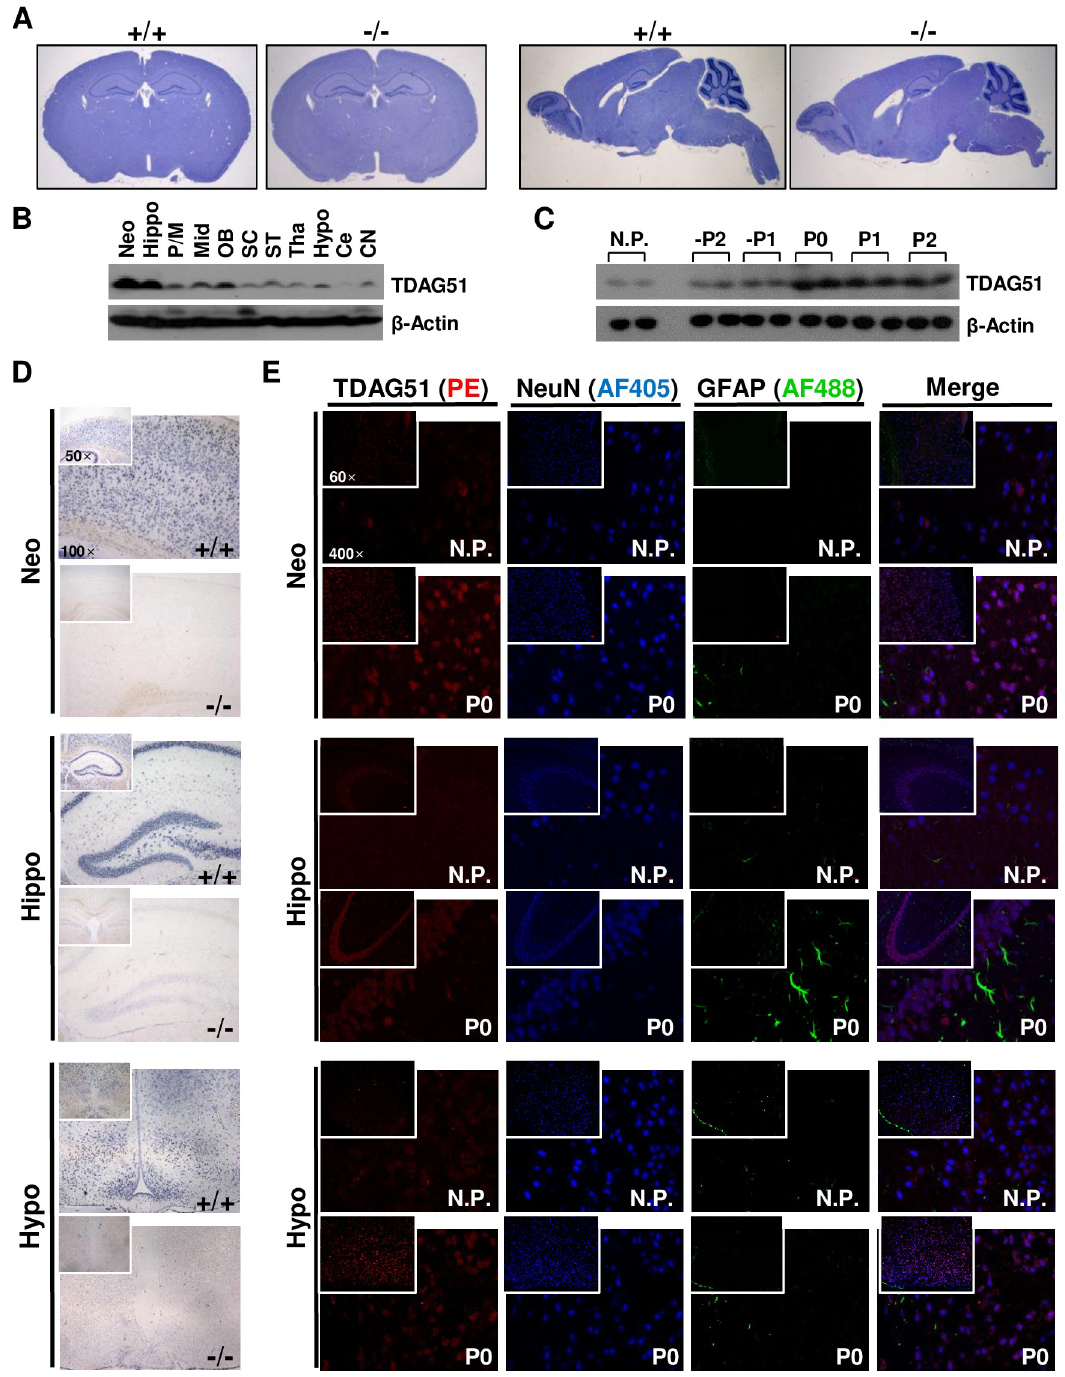
Fig 3. Expression of TDAG51 in brain tissues. (A) TDAG51 expression in brain sections from nonpregnant female mice. Histological images of coronal brain sections (top and left panels) and sagittal brain sections (top and right panels) were obtained by hematoxylin staining. +/+, TDAG51 +/+ . -/-, TDAG51 -/- . (B) TDAG51 expression in mouse brain tissues. TDAG51 expression in brain tissues from nonpregnant female mice was analyzed by a western blot analysis with an anti-TDAG51 antibody. β -Actin was used as a loading control. Neo, neocortex. Hippo, hippocampus. P/M, pons/medulla. Mid, midbrain. OB, olfactory bulb. SC, spinal cord. ST, stria terminalis. Tha, thalamus. Hypo, hypothalamus. Ce, cerebellum. CN, cerebral nuclei. (C) Comparison of the TDAG51 expression levels in the brain during pregnancy, parturition and postpartum periods. TDAG51 expression levels in two mice per group were analyzed by a western blot analysis using an anti-TDAG51 antibody. Nonpregnant female mice (N.P.) were